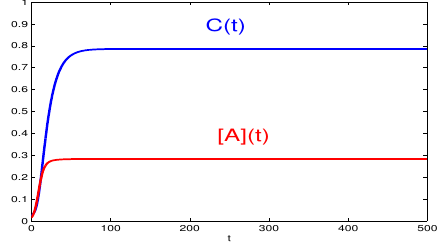
Figure 3. Simulation solution of (1.1):the equilibrium E ∗ is asymptotically stable, when τ =